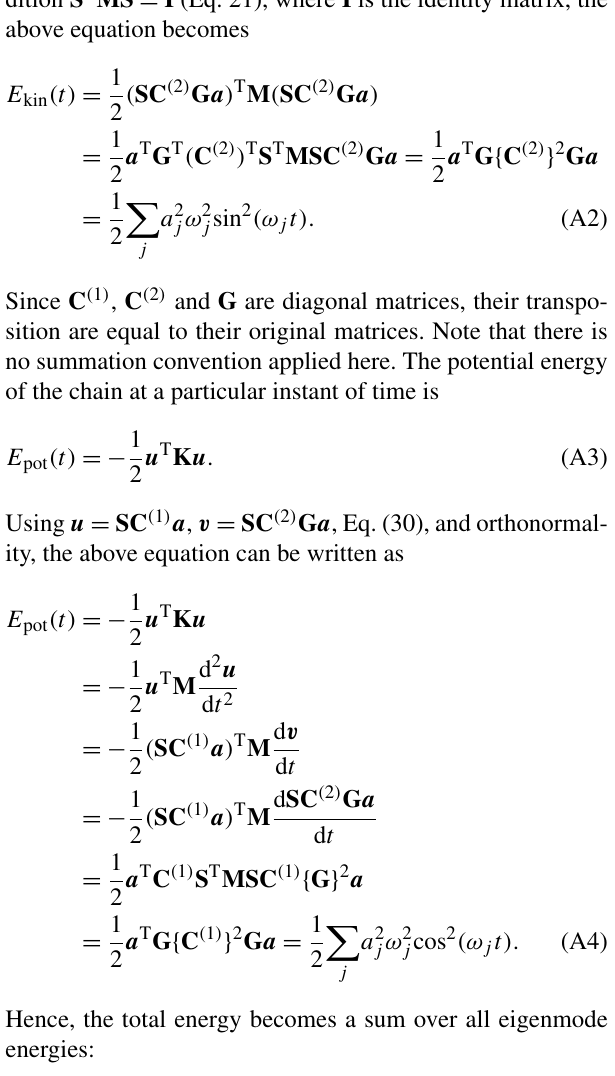
Figure A1. Multiplicative Factor a j for normal distribution ob- tained after ensemble averaging